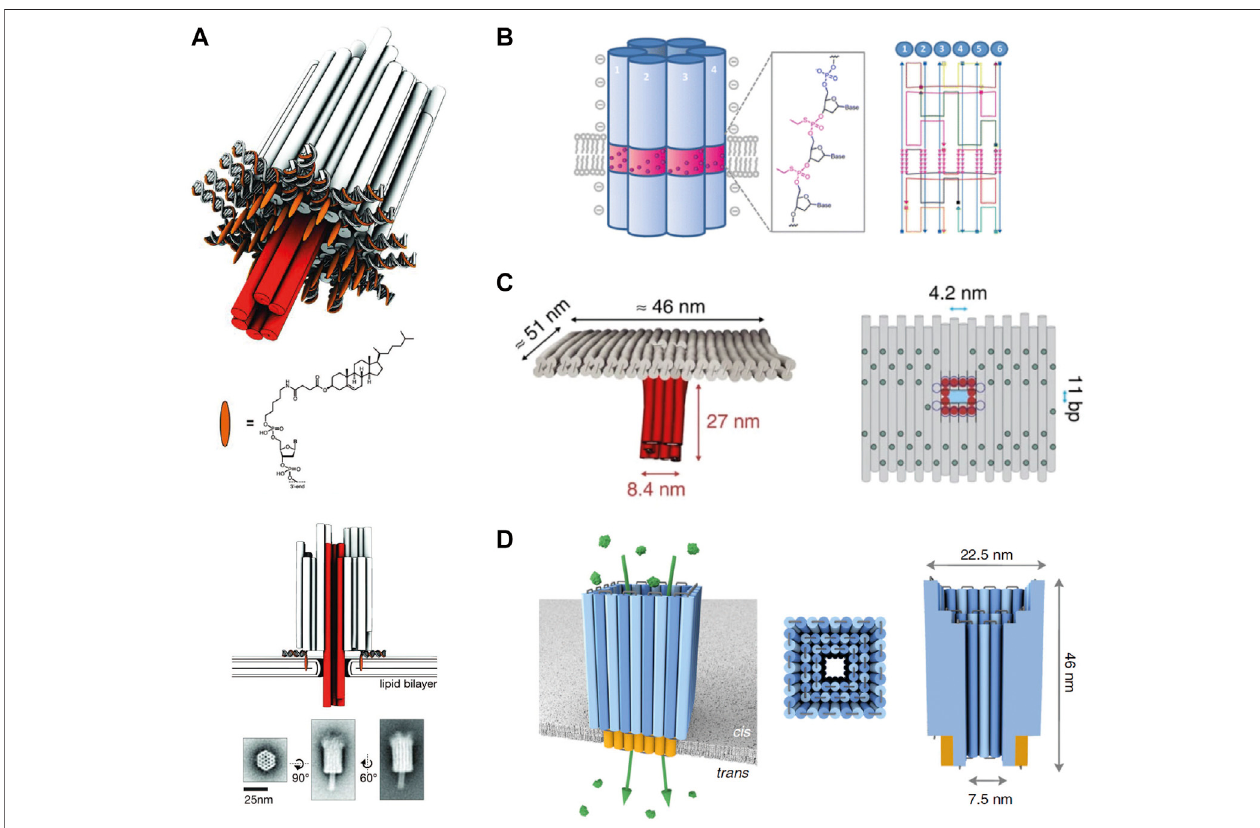
FIGURE 1 | Architectures of membrane-embedded DNA nanopores. (A) , Design and TEM images of the fi rst described membrane-embedded DNA nanopore. Reprinted (adapted) with permission from (Langecker et al., 2012). (B) , Schematic illustration and design of the second described cylindrical DNA nanopore. Reprinted (adapted) with permission from (Burns et al., 2013). Copyright (2021) American Chemical Society. (C) , Architecture of the T-shaped DNA nanopore with a diameter of ∼ 4 nm. Reprinted (adapted) with permission from (Krishnan et al., 2016). (D) , Protein-conductive DNA nanopore with a diameter of ∼ 7.5 nm. Reprinted (adapted) with permission from (Diederichs et al.,